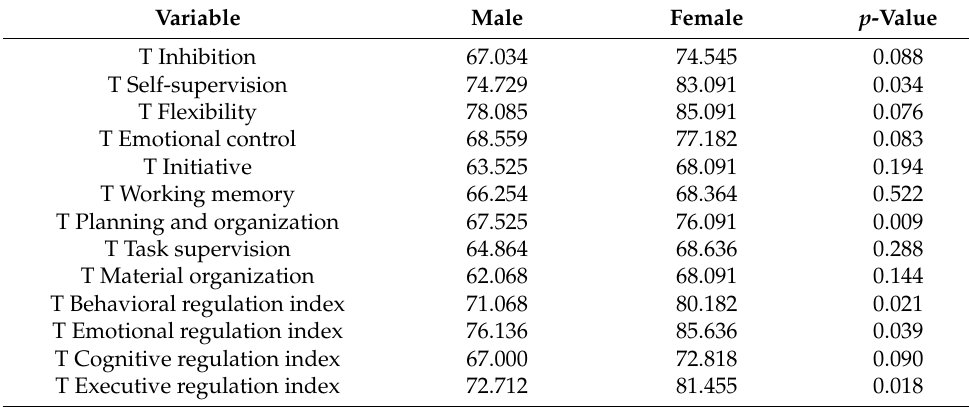
Table 3. Variant analysis according to the sex of people with